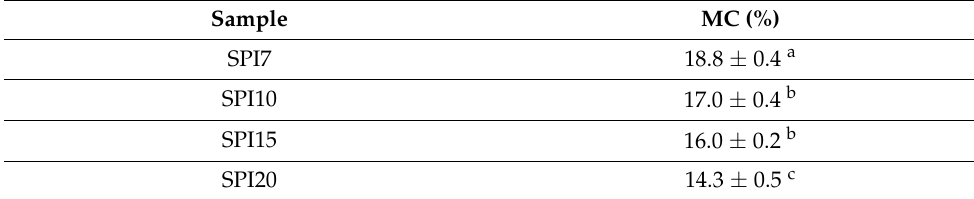
Table 2. Moisture content (MC) values of SPI7, SPI10, SPI15, and SPI20